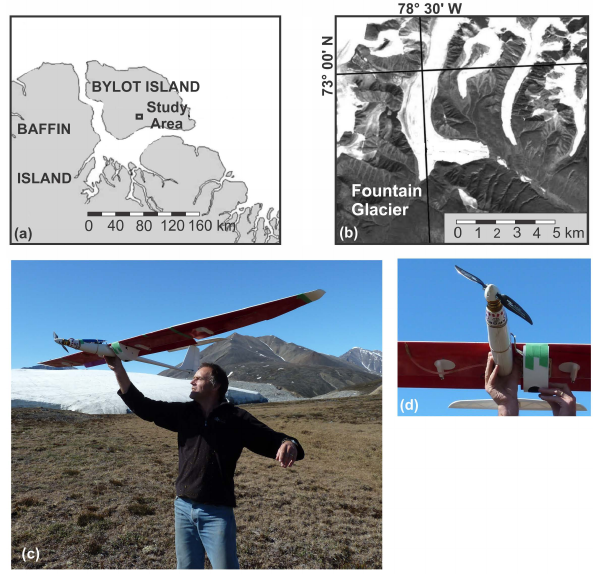
Fig. 1. (a) Location of site on Bylot Island, (b) Landsat 7 image of Fountain Glacier, (c) carrying out pre-flight checks for the Out- lander UAV, (d) close-up of propeller assembly showing the loca- tion of the camera